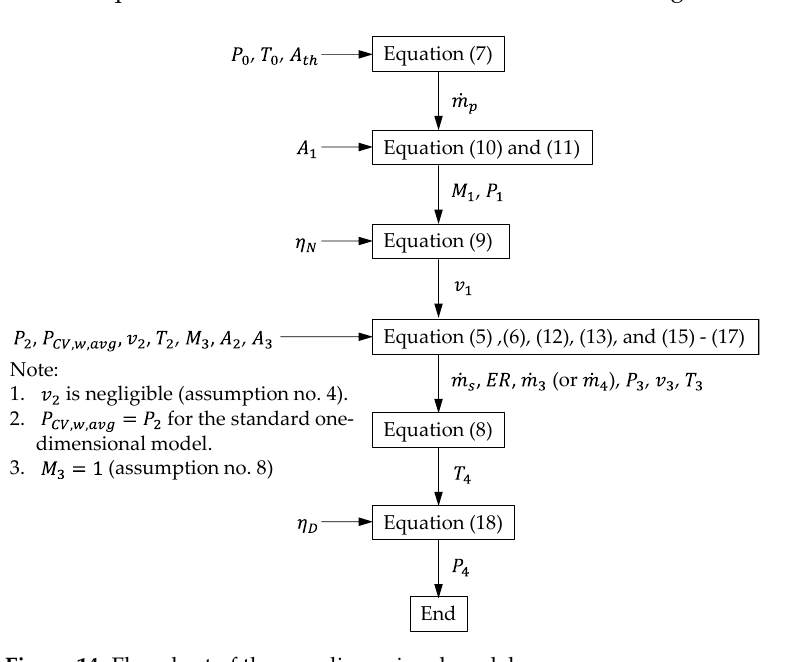
Figure 14. Flowchart of the one-dimensional model.